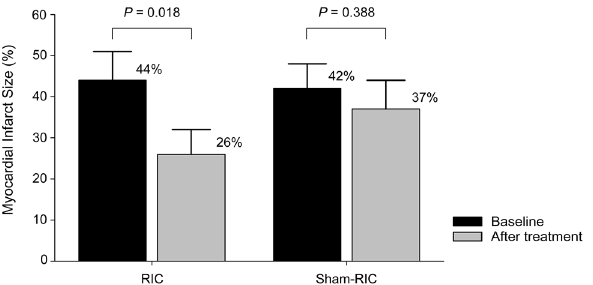
Figure 4. Infarct size of the rat hearts perfused with serum dialysate from patients before and after remote ischemic conditioning or sham treatment. RIC remote ischemic conditioning.